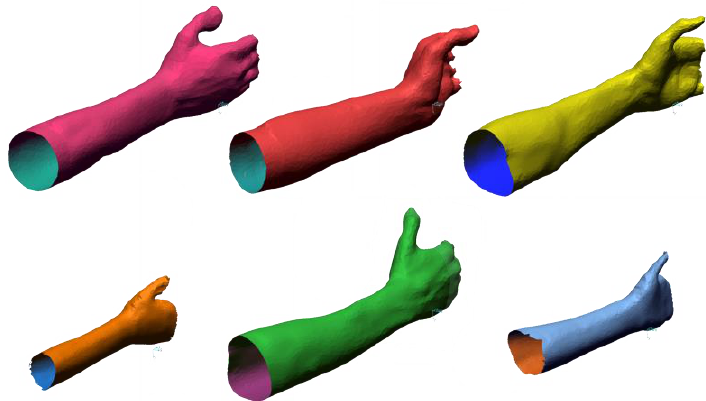
Figure 13. Arm models used in the analysis. Figure 13 . Arm models used in the analysis. Figure 13 . Arm models used in the analysis.